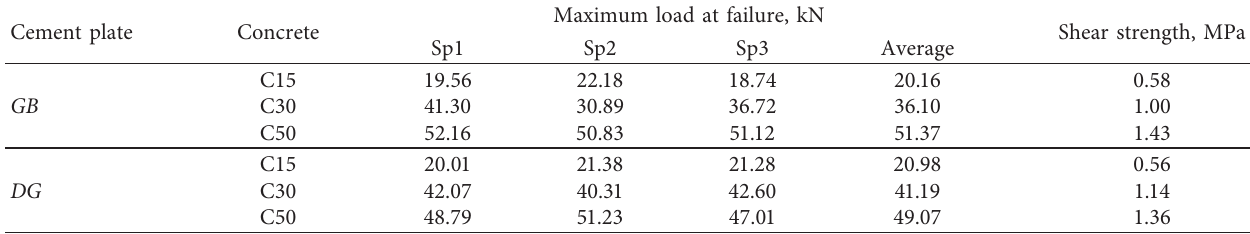
Table 6: A summary of the maximum shear load at failure and shear strength of the plate-concrete interfaces for composite samples with different cement plates and concretes. Cement plate